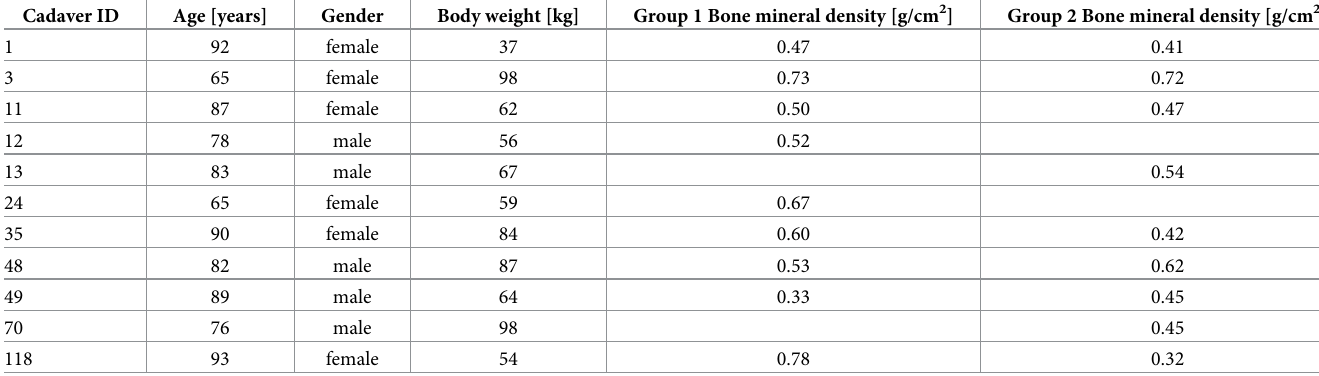
Table 1. Baseline data of the body